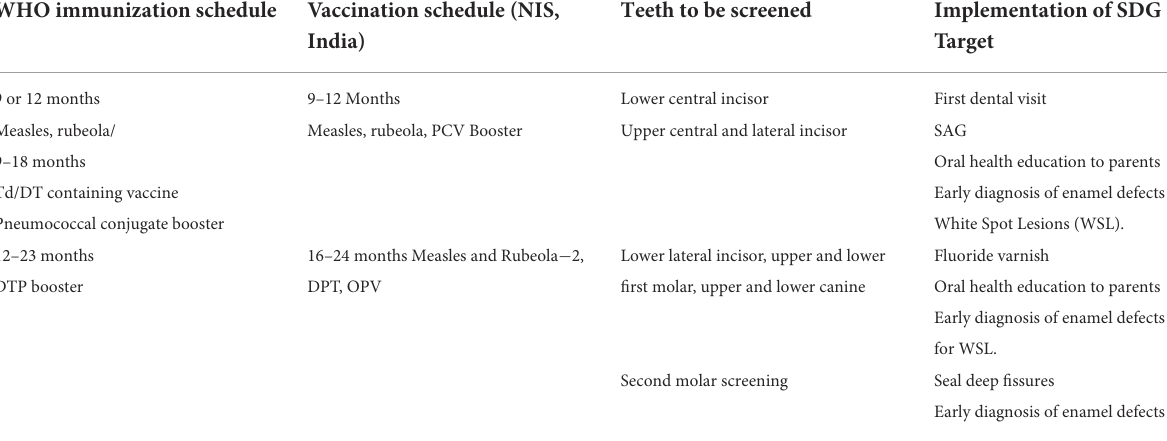
TABLE 1 Integrating vaccination schedule with eruption of various primary